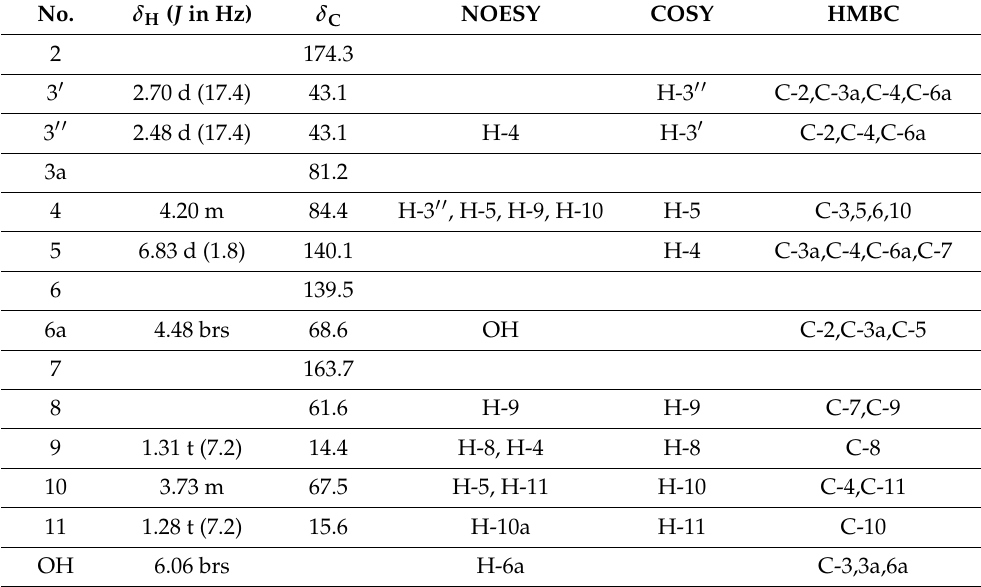
Table 3. 1 H NMR Data ( δ in ppm, J in Hz) of compound 5 (600